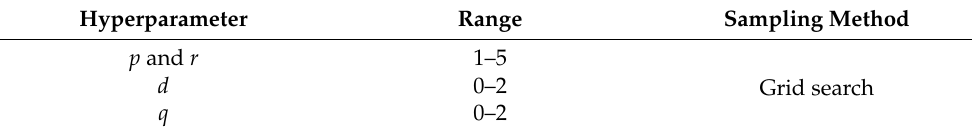
Table 4. Hyperparameter tuning space related to ARIMAX.